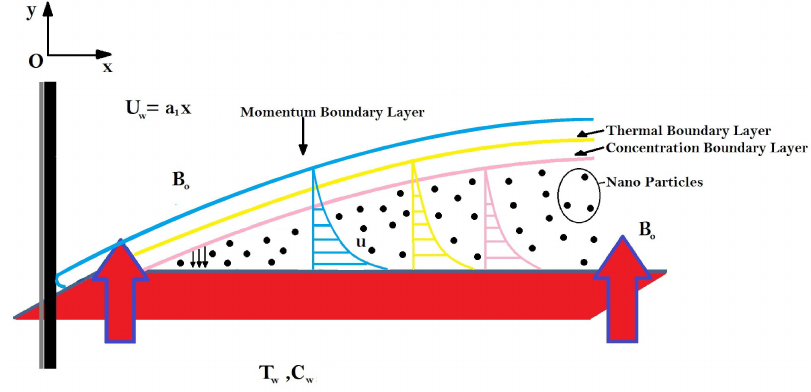
Figure 1. Problem